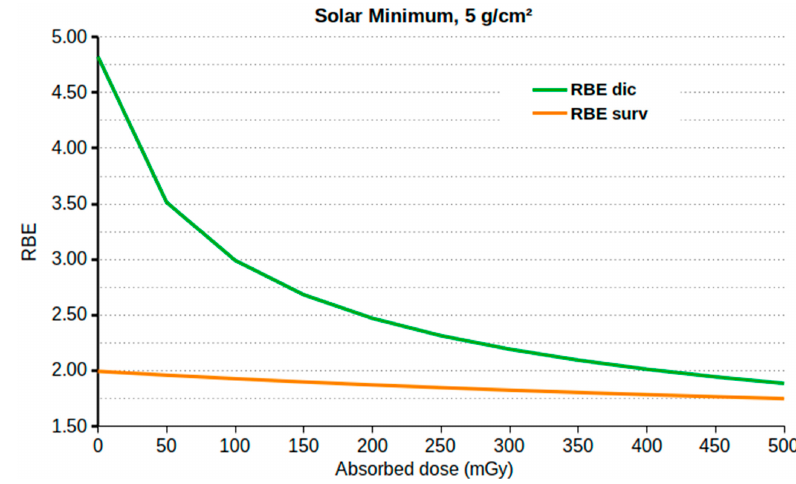
Figure 4. RBE for lymphocyte dicentrics ( upper line) and cell survival ( lower line) as a function of the absorbed dose for the sample case of 5 g/cm 2 Al shielding at solar